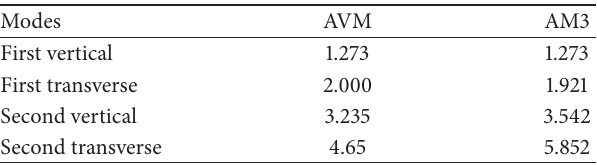
Table 7: Experimentally and mathematically identified modal frequencies